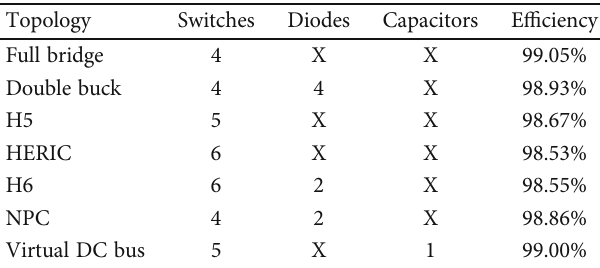
Table 8: Comparison of number of elements and